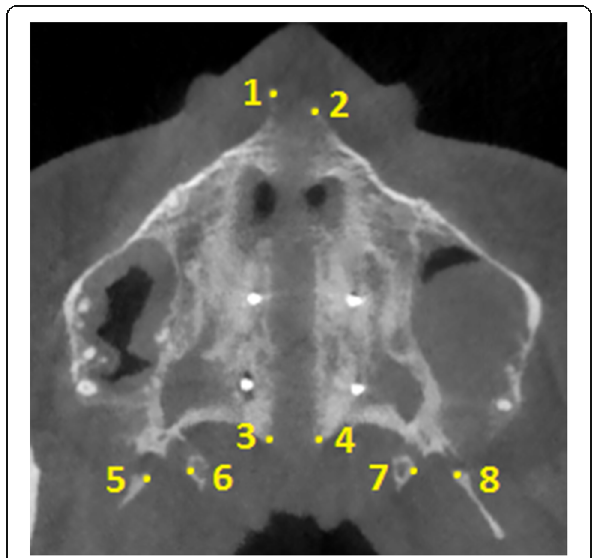
Fig. 6 Landmarks identified in the axial palatal section in the post-expansion CBCT. 1 Right anterior nasal spine (Rt ANS), 2 left anterior nasal spine (Lt ANS), 3 right posterior nasal spine (Rt PNS), 4 left posterior nasal spine (Lt PNS), 5 most medial point of the lateral plate of the right pterygoid process (Rt Lat Pter), 6 most lateral point of the medial plate of the right pterygoid process (Rt Med Pter), 7 most lateral point of the medial plate of the left pterygoid process (Lt Med Pter), 8 most medial point of the lateral plate of the left pterygoid process (Lt Lat Pter)